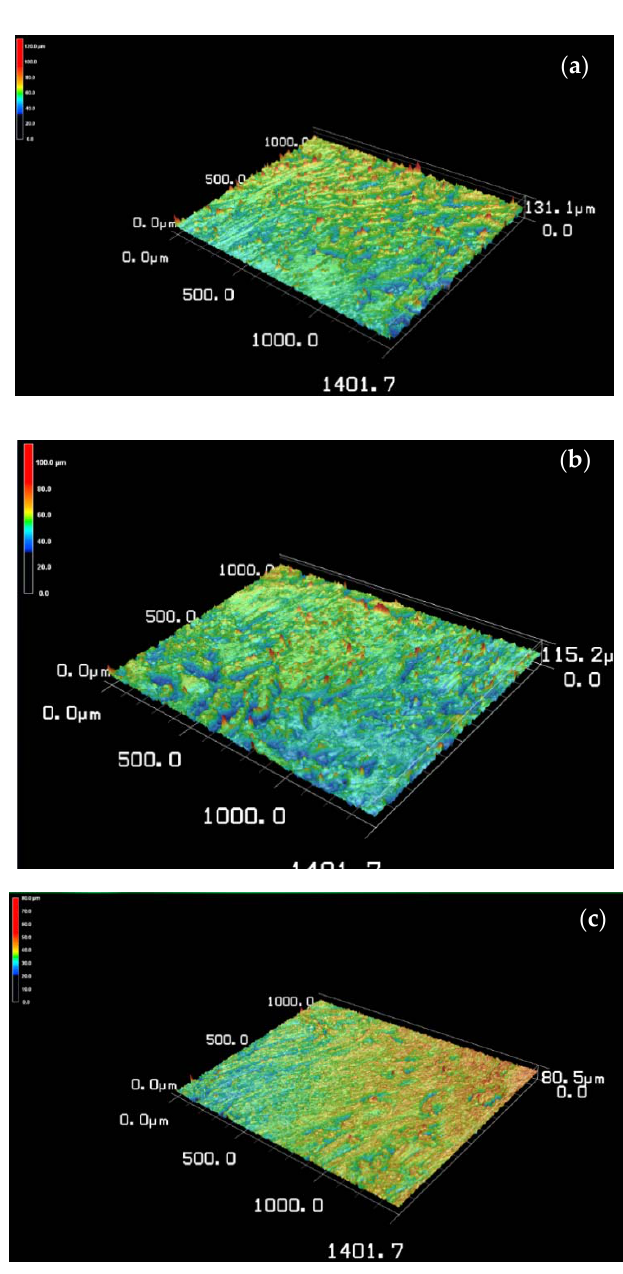
Figure 6. 3D laser images of the surface roughness of BPCs made with 30% biochar prepared at 315 °C ( a ), 400 °C ( b ) and 445 °C ( c ).